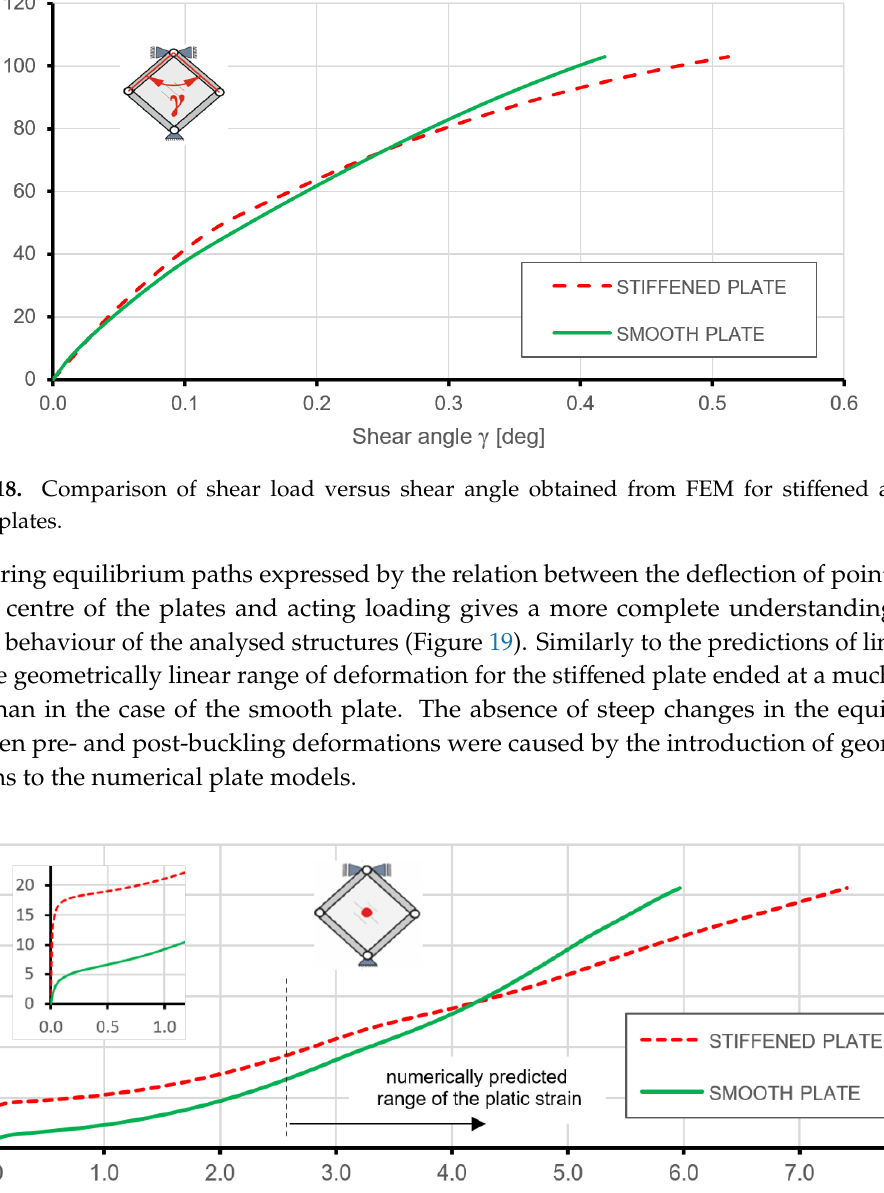
Figure 18. Comparison of shear load versus shear angle obtained from FEM for stiffened and smooth plates.